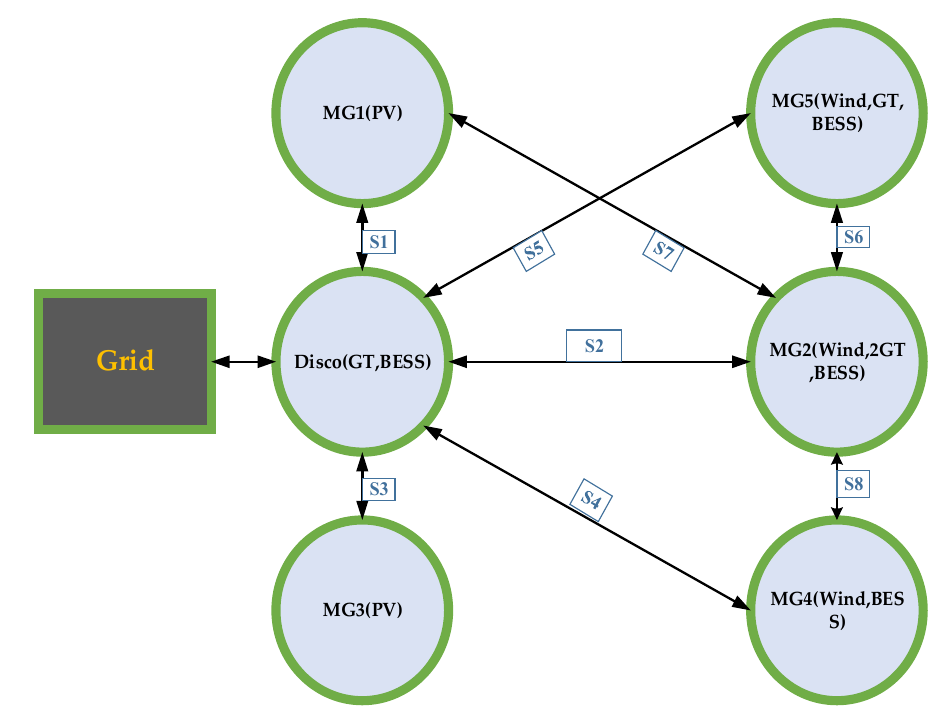
Figure 3. The proposed idea.